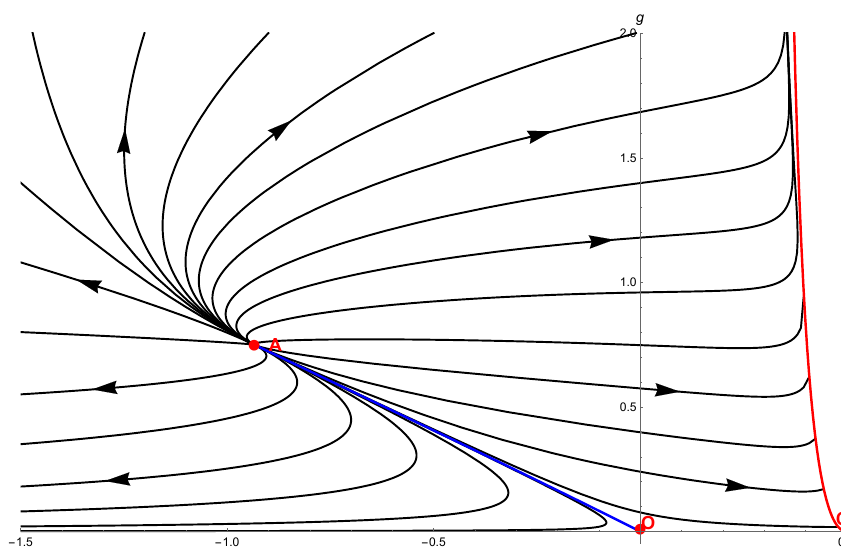
Figure 5 . Phase diagram depicting the RG (cid:13)ow of gravity coupled to the matter content of the standard model in D = 3 + 1 spacetime dimensions. Similarly to the pure gravity case, the phase diagram is dominated by the interplay of the NGFP (point \A") controlling the (cid:13)ow for ultra-high energies and the GFP (point \O") governing its low-energy behavior. The singular locus (4.5) is depicted by the red line and arrows point towards lower values of k